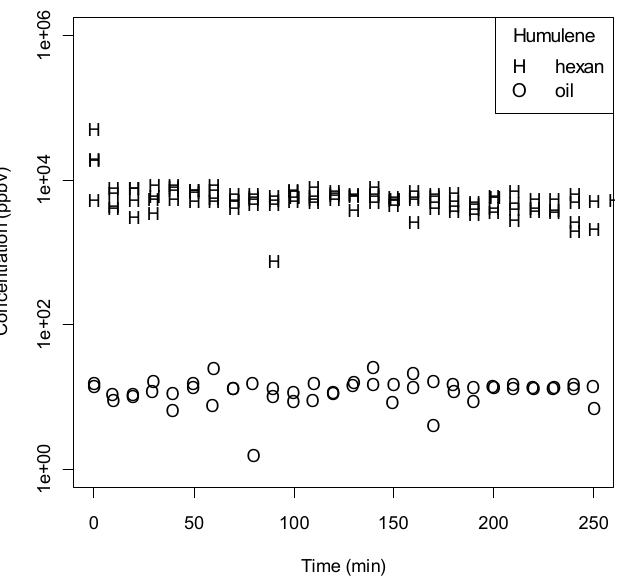
Figure 4. Time evolution for α